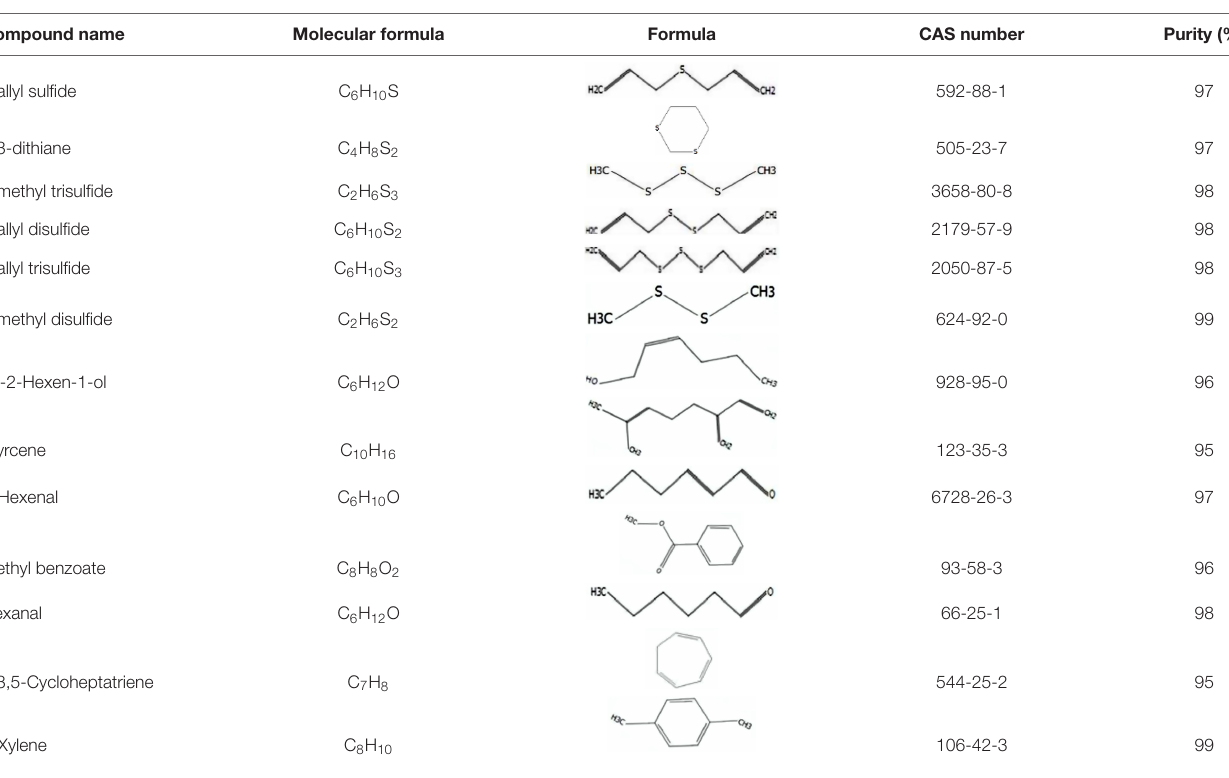
TABLE 1 | List of odor